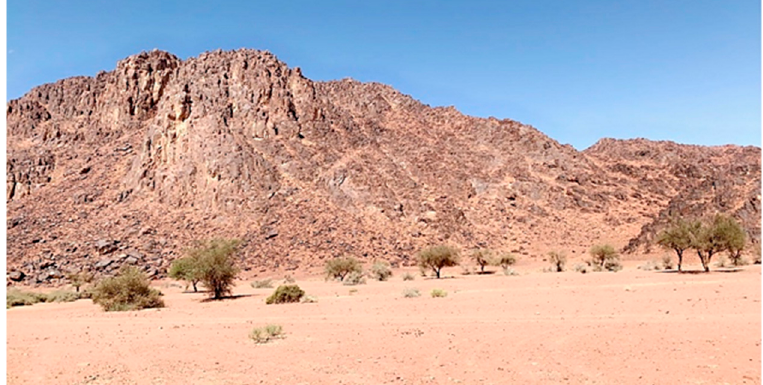
Figure 1. The Aja and Salma Mountains in Hail.